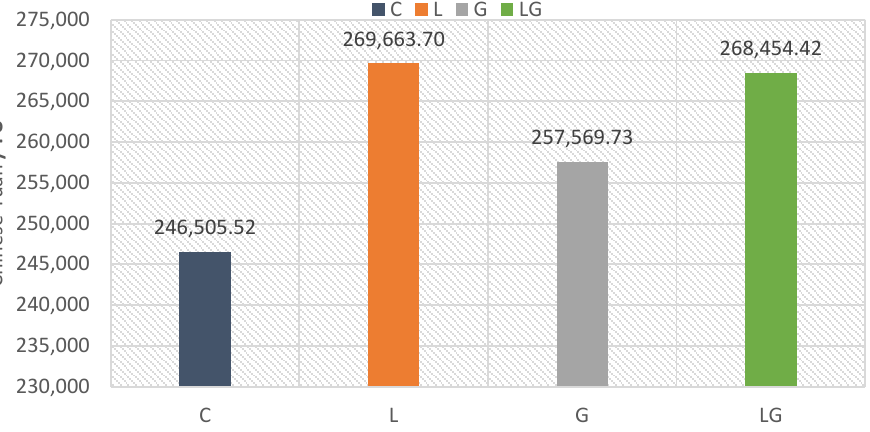
Figure 7. Weighting profiles of the different asphalt mixtures using the Ecotax2002 method.